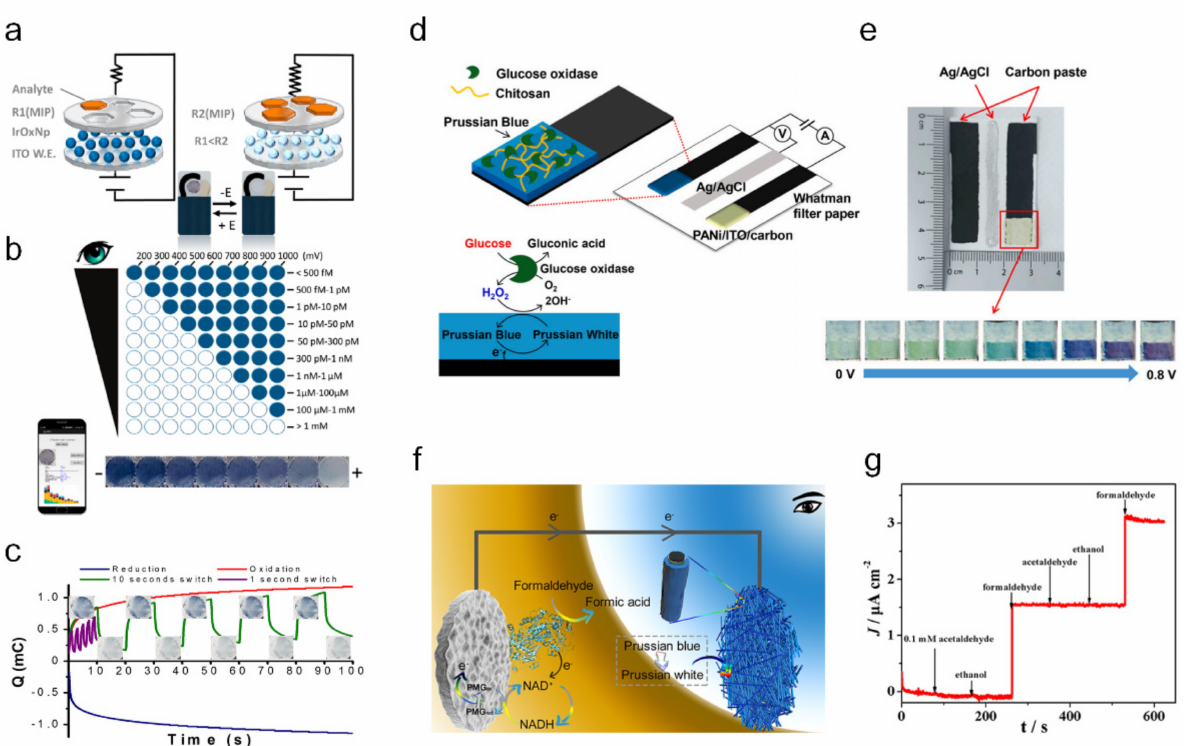
Figure 4. Visual biosensing system based on the EC readout (( a – c ) adapted with permission from ref. [48], copyright 2018 American Chemical Society, ( d , e ) adapted with permission from ref. [49], copyright 2022 Elsevier, and ( f , g ) adapted with permission from ref. [50], copyright 2019 American Chemical Society). ( a ) Schematic of the IrO x NPs electrochromism induced by the change in resistance in molecularly imprinted polymer due to chlorpyrifos analyte. ( b ) Visual detection of chlorpyrifos under varied oxidation potentials and chlorpyrifos concentrations. ( c ) Charge (mC) change of the IrO x NPs during 100 s of oxidation (red), reduction (blue), and redox cycles with a switch of 1 s (purple) and 10 s (green). ( d ) The schematic and operating mechanism of the paper-based electrochromic glucose sensor. ( e ) Photographs of the working, reference, and counter electrodes (from left). EC behavior of the deposited PANI under different potentials (blue box). ( f ) Working principle of the enzymatic self-powered biosensor (ESPB) in formaldehyde detection. ( g ) Short-circuit current of the ESPB by successive addition of 0.1 mM acetaldehyde, 0.1 mM ethanol, and 0.1 mM formaldehyde, which indicates selectivity toward